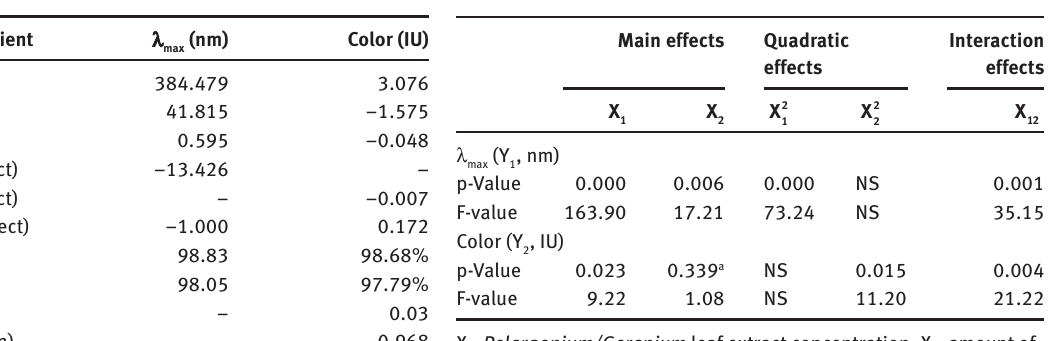
Table 3: Regression coefficients, R 2 , R 2 -adj, and p-values for the final reduced models.